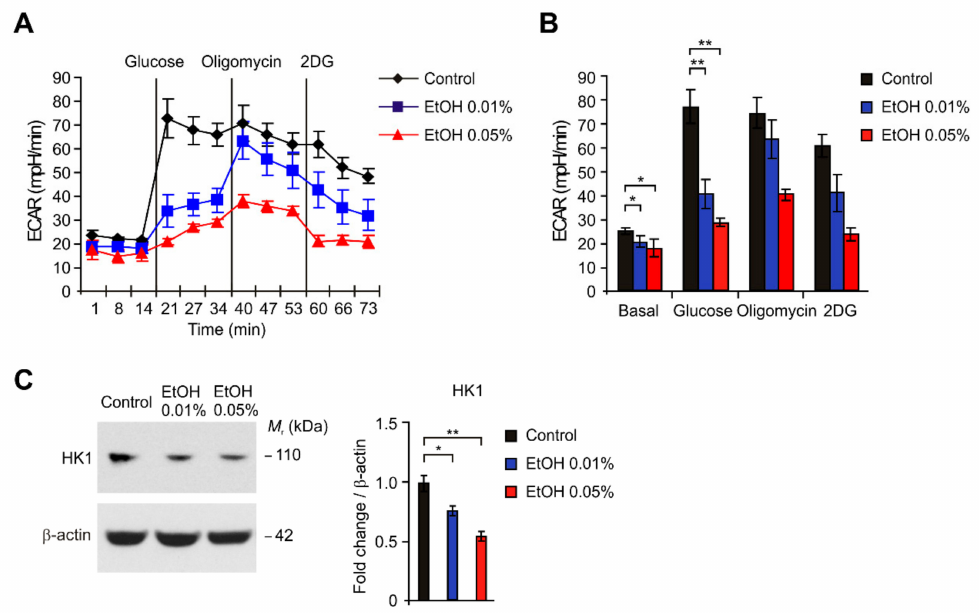
Figure 3. HK1-dependent glycolysis is suppressed by alcohol exposure in HEI-OC1 cells. ( A ) The levels of extracellular acidification rate (ECAR) for glycolysis of glucose and ( B ) quantification of ECAR levels from HEI-OC1 cells treated with ethanol (EtOH, 0.01% or 0.05%) or vehicle (Control) for 4 h. Data are representative of three independent experiments. Data are mean ± SEM. ** p < 0.01, * p < 0.05 using the two-tailed Student’s t-test. ( C ) Representative immunoblot analysis for HK1 ( left ) and quantification for HK1 protein levels ( right ) from HEI-OC1 cells treated with ethanol (EtOH, 0.01% or 0.05%) or vehicle (Control) for 4h. For immunoblots, β -actin was used as loading control. Data are representative of three independent experiments. Data are mean ± SEM. ** p < 0.01, * p < 0.05 using the two-tailed Student’s t